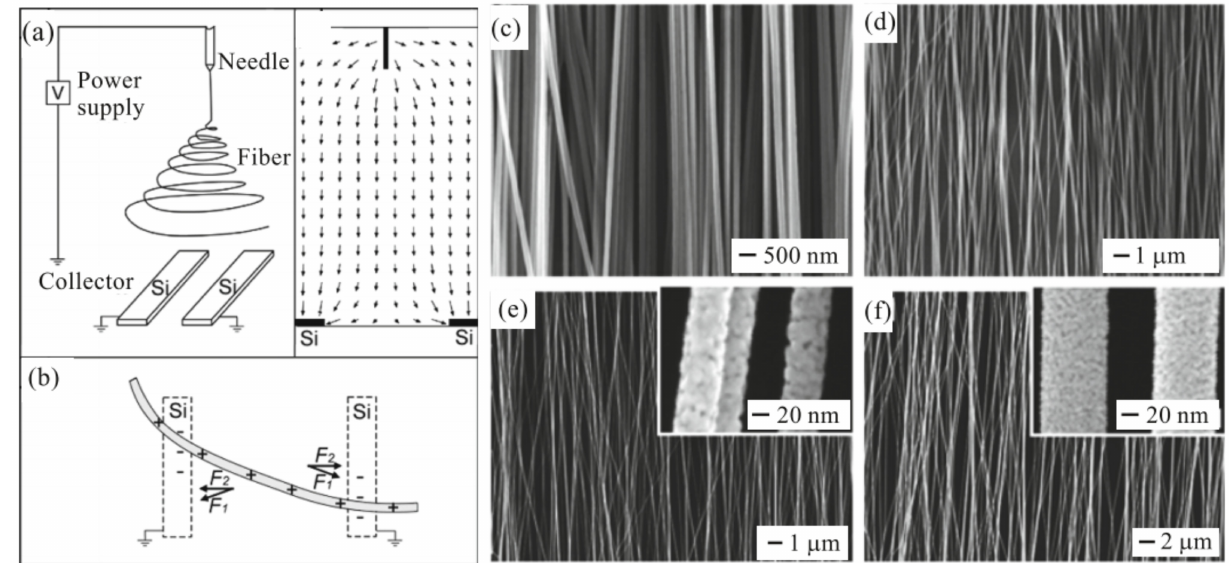
Figure 6. ( a ) Schematic illustration of the setup for collecting nanofibers as a uniaxially aligned array. The collector contains an insulating void, such as the air gap between two strips of silicon wafers. ( b ) Electrostatic force analysis of a charged nanofiber spanning across two silicon strips. The orientation of the nanofiber is mainly controlled by the stretching force originating from the attractive electrostatic forces. ( c – f ) SEM images of uniaxially aligned nanofibers made of ( c ) carbon, ( d ) anatase TiO 2 , ( e ) NiFe 2 O 4 and ( f ) TiO 2 /PVP. Reprinted with permission from [101]. Copyright 2003 American Chemical